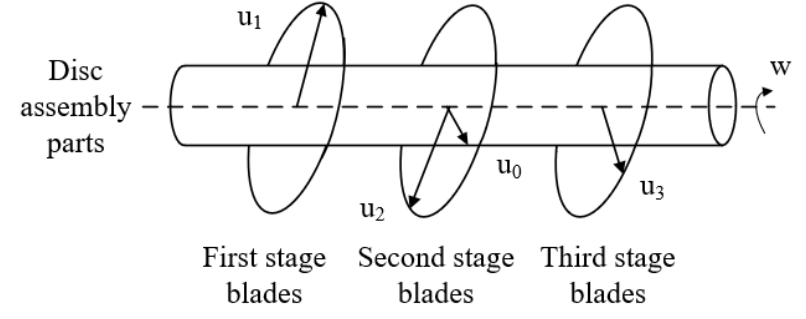
Figure 5. Superposition of unbalance schematic.